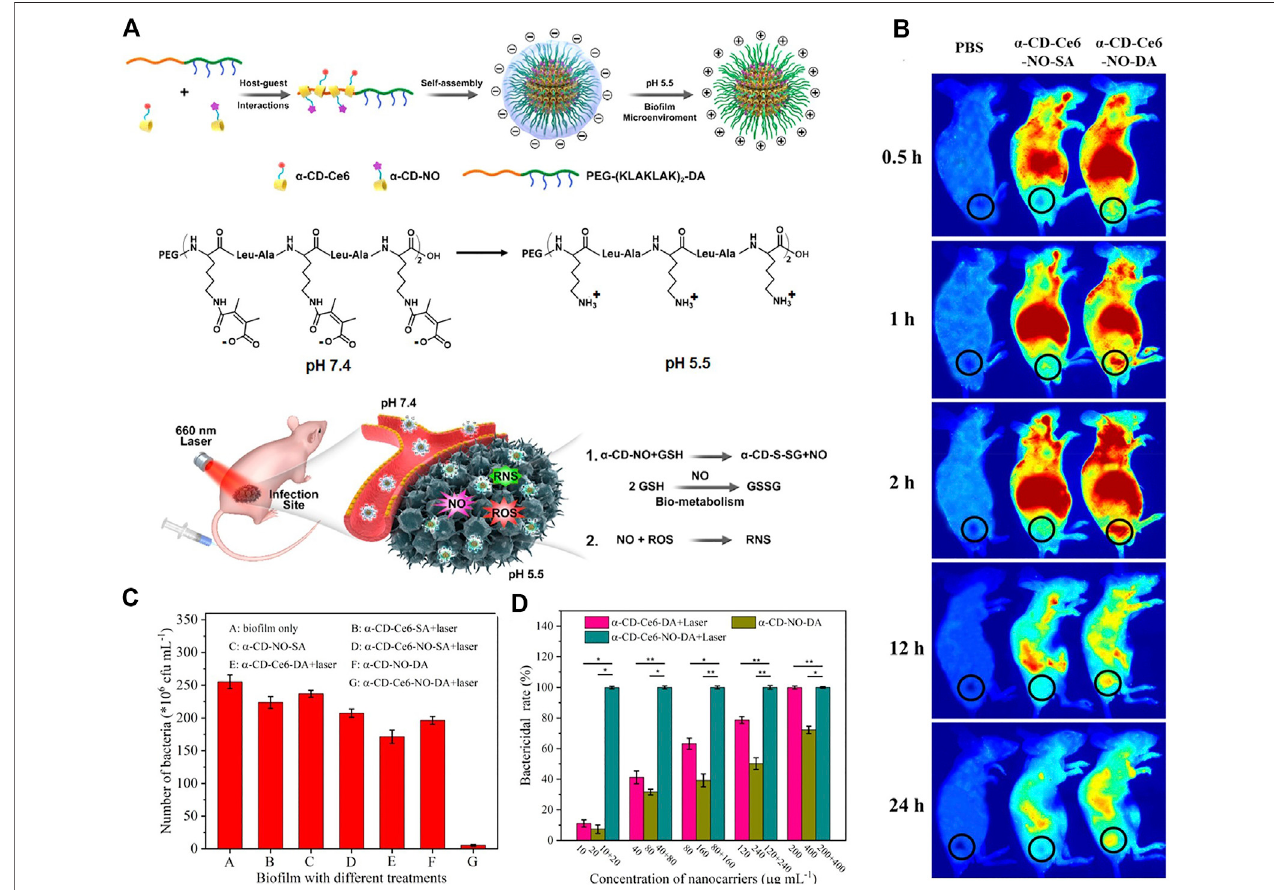
FIGURE13|(A) Schematicdiagramoftheacid-activated chargereversalofPEG-(KLAKLAK)2-DAat pH5.5and themechanismsoftheMRSAbio fi lmassociated infectioneradicationbysynergisticeffectsbetweenROSandNOproducedby α -CD-Ce6-NO-DAnanocarriers; (B) invivo time-dependentbody fl uorescenceimagingof the MRSA bio fi lminfected mice after various treatments; (C) related bactericidal results ofdifferent nanocarriers withthe same Ce6 concentrationunderlaser irradiation, characterized by the standard plate counting assay. (D) In vivo bactericidal rates of various treatments. Reprinted with permission from Hu et al. (2019).